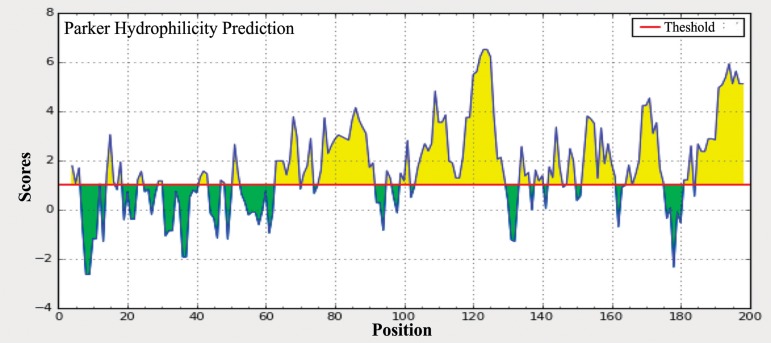
Parker hydrophilicity prediction of Arabian camel HSPB-1 protein.The threshold is 1.0. The regions having β-turns in the protein are shown in yellow color, above the threshold value.